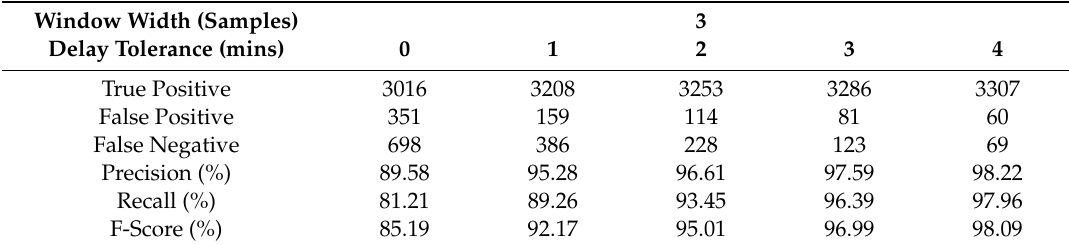
Table 4. Performance evaluation in the context of delay tolerance.